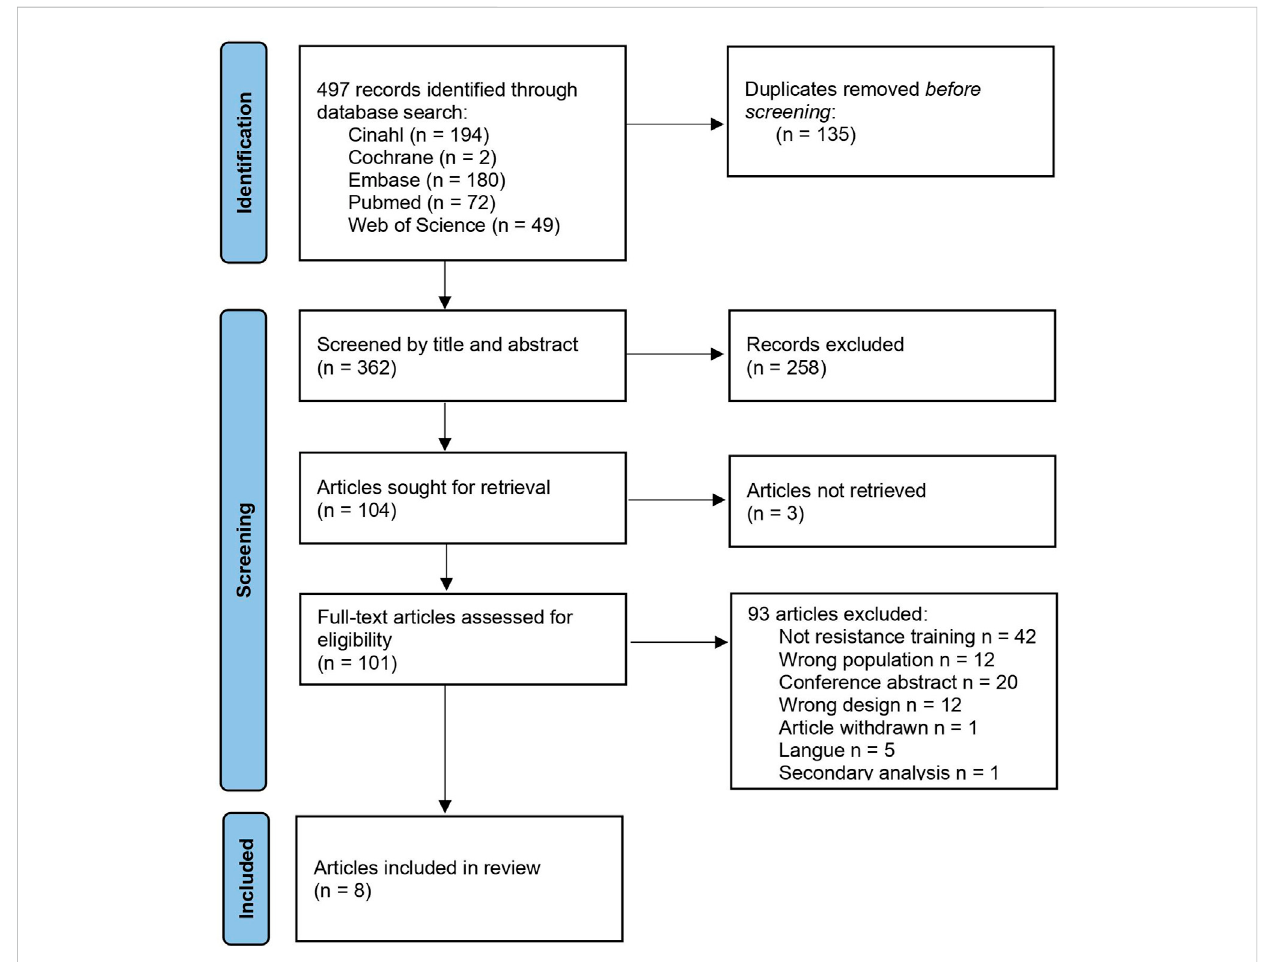
FIGURE 1 PRISMA-ScR fl ow diagram of study